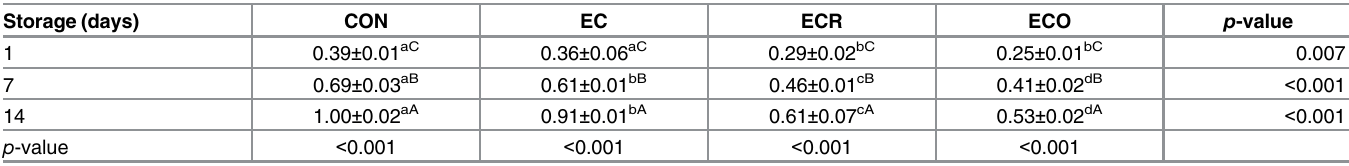
signi fi cantly different ( p < 0.05). CON – Control without edible coating; EC – Meat with edible coating; ECR – Meat with edible coating and rosemary essential